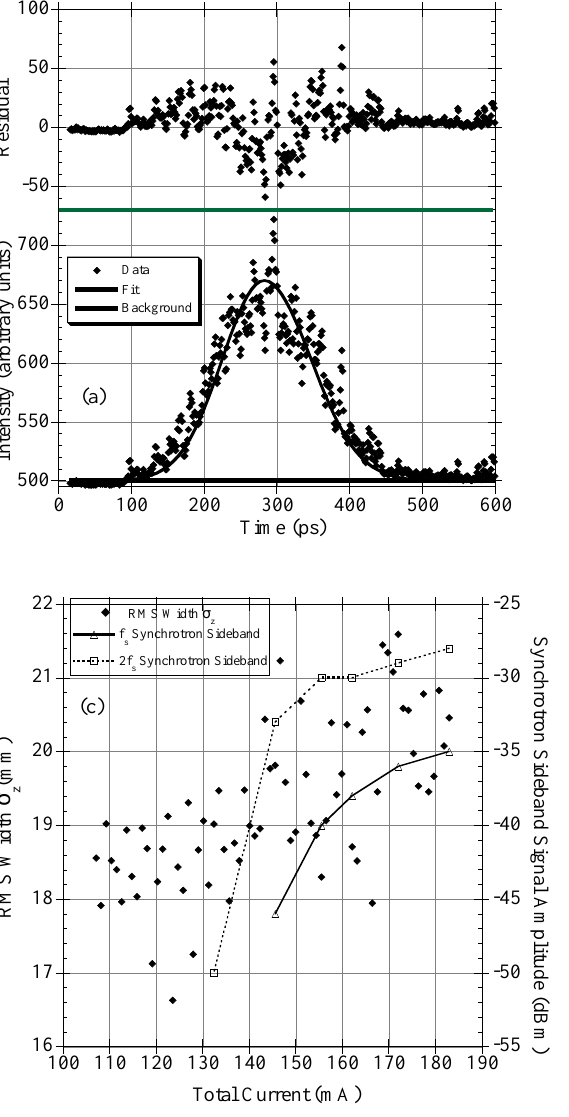
FIG. 28. (a) A single data acquisition of the longitudinal bunch distribution fit to the mean stable bunch distribution. The beam is declared unstable due to the presence of the f r 6 f s and f r 6 2 f s signals in the beam spectra. The current is 170 mA total. The residual between the distribution and the fit is plotted above the distribution. (c) The bunch length and synchrotron sideband amplitudes for f r 6 f s and f r 6 2 f s signals between the current of 183–105 mA. (d) The bunch length between the current of 262–247 mA. The amplitude of the beam spectra was not measured during this experiment, but the f r 6 f s and f r 6 2 f s signals were present during the